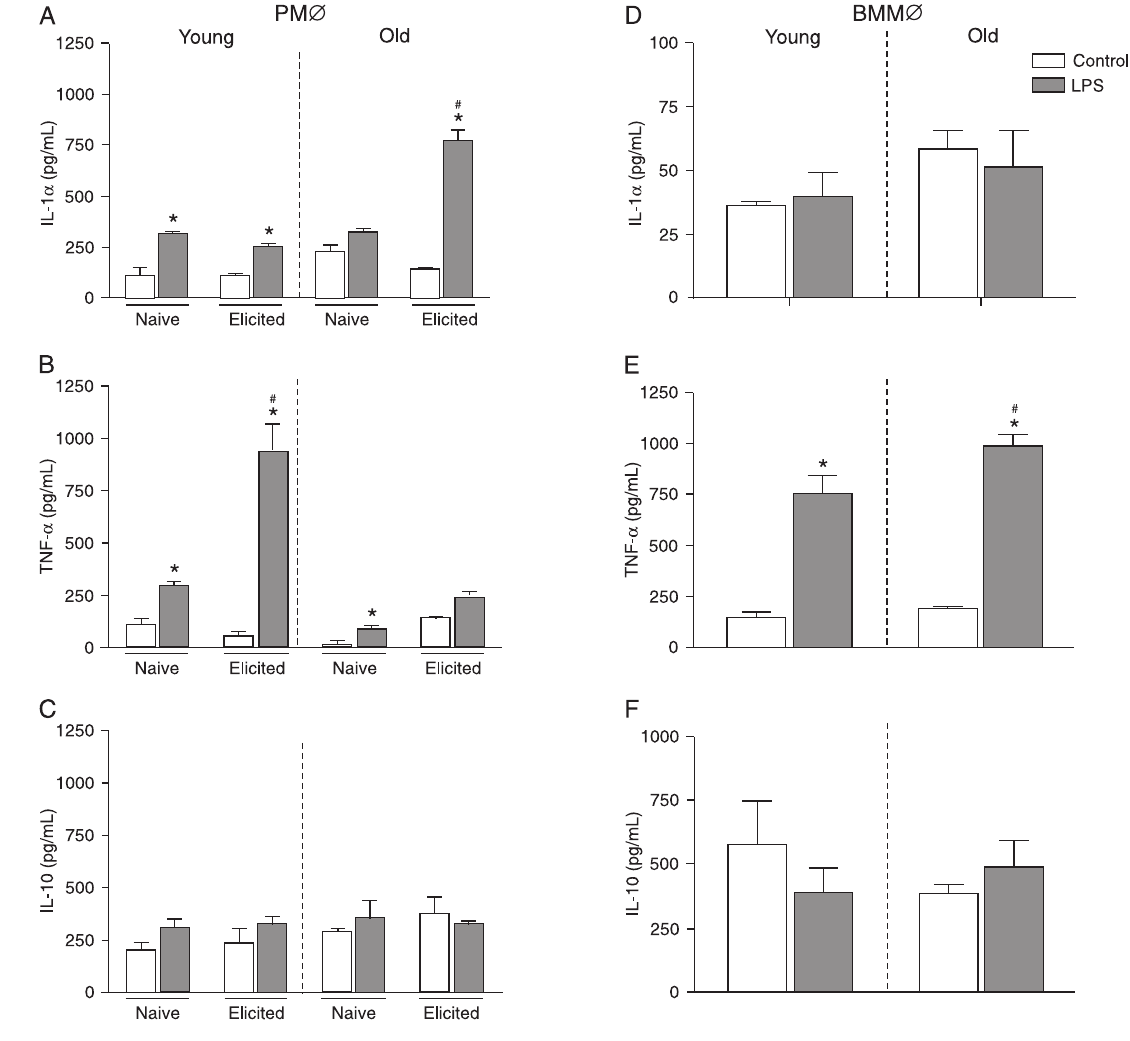
Figure 5. Aging affects cytokine production in peritoneal macrophages and bone marrow-derived macrophages of BALB/c mice (N = 6 per group). Naive and thioglycolate-elicited peritoneal macrophages (Panels A, B, and C) and bone marrow-derived macrophages (Panels D, E, and F) from young and old mice were prepared and cultured as described in the legend to Figure 4. The culture super- natants were used for the detection of interleukin-1α (IL-1α; Quantikine M murine; test sensitivity, 5 pg/mL), tumor necrosis factor-α (TNF-α; DuoSet ELISA Kit; test sensitivity, 62.5 pg/mL) and interleukin-10 (IL-10; Pharmingen; test sensitivity, 30 pg/mL). All studies were conducted in triplicate. Bars indicate the means ± SEM of the respective cytokines detected in three independent experiments. *P ≤ 0.05 compared to control (Student t